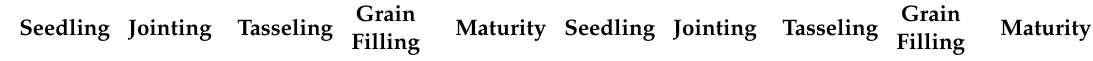
Table 4. Interactive impact of straw mulch and biochar application rates on the leaf area index of the maize